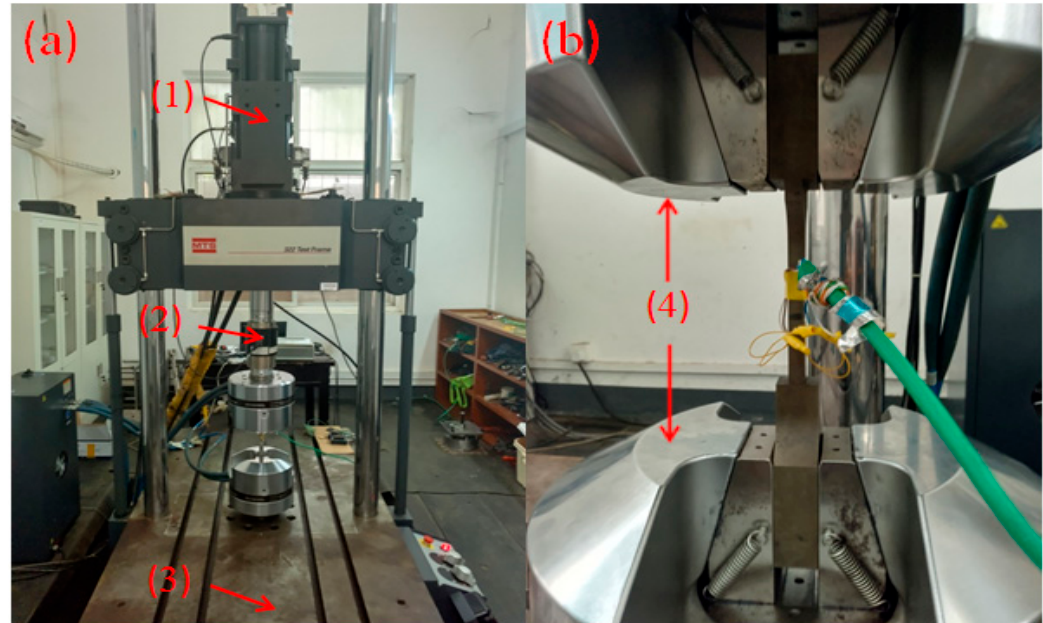
Figure 1. Load frame of the test ( a ), the installation of designed T-type specimen ( b ). A servo-hydraulic actuator (1), a controller (2), the platform (3), grippers (4).